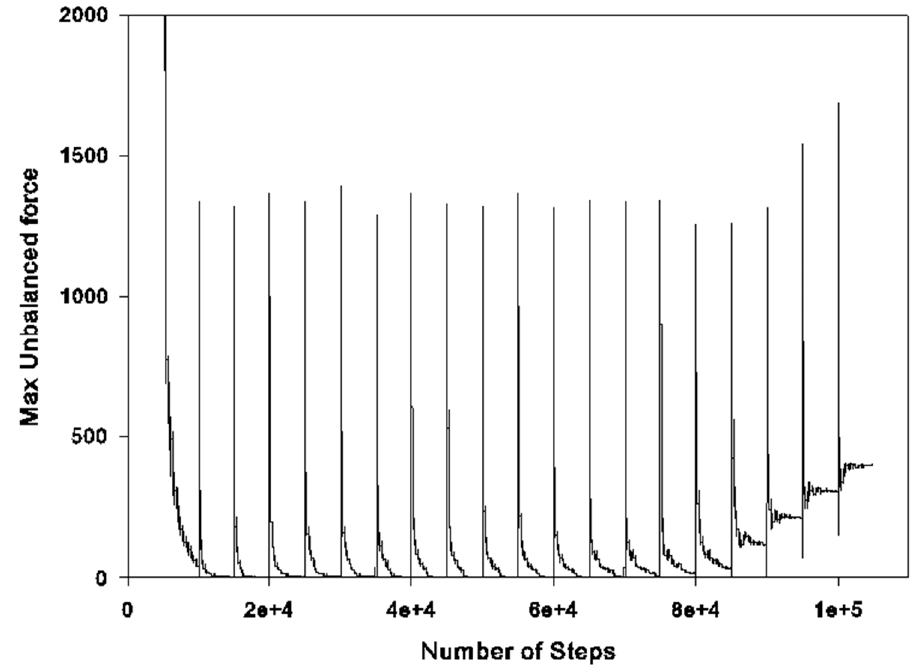
Figure 5. Unbalanced force history plot ( C/D = 3, γ D/S u = 4, E = 200 S u ).